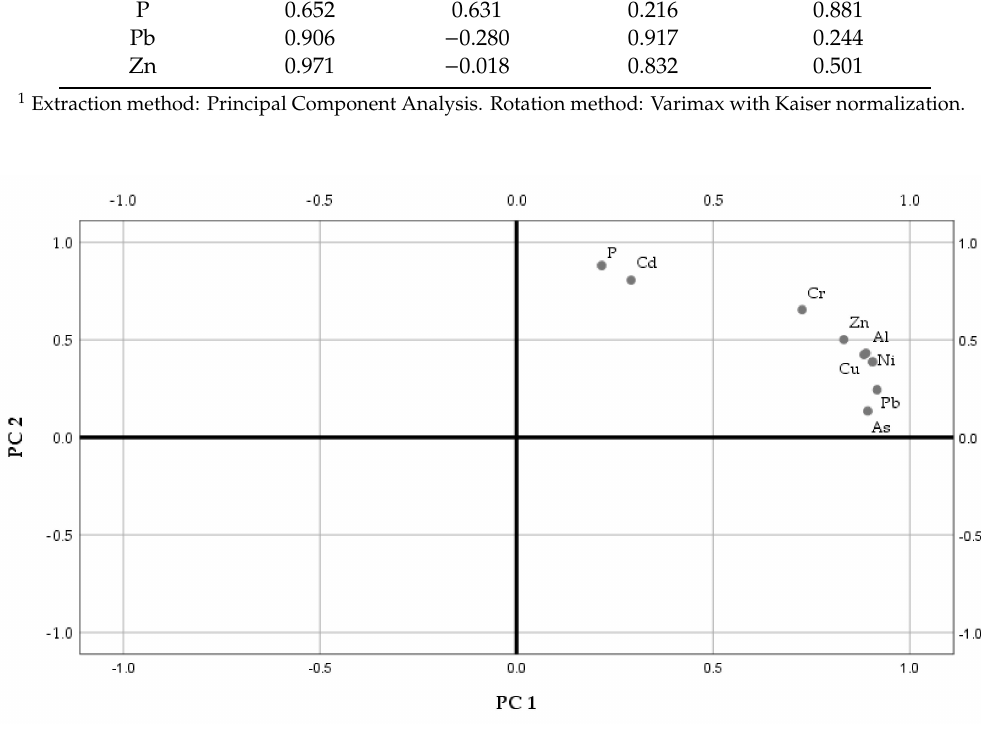
Figure 4. Loading Plots of the two PCs obtained for the data